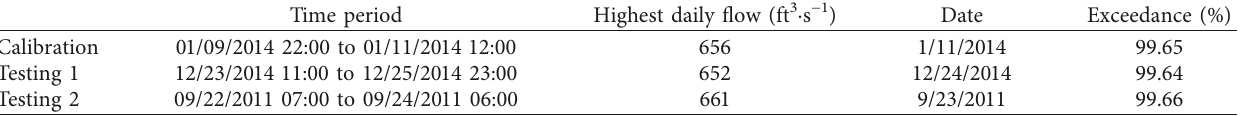
Table 1: Calibration and testing time periods and associated flow statistics of the Gills Creek watershed.